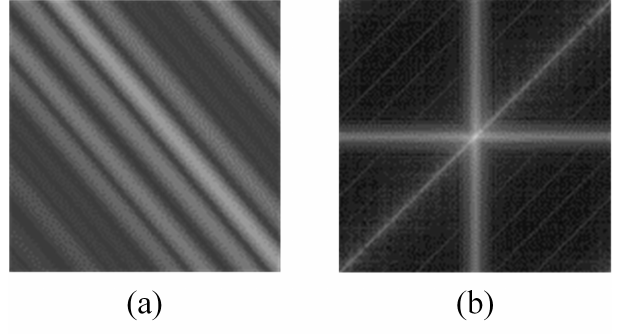
Figure 10. Example of synthetic STI. ( a ) A synthetic STI, ( b ) The FFT image of ( a